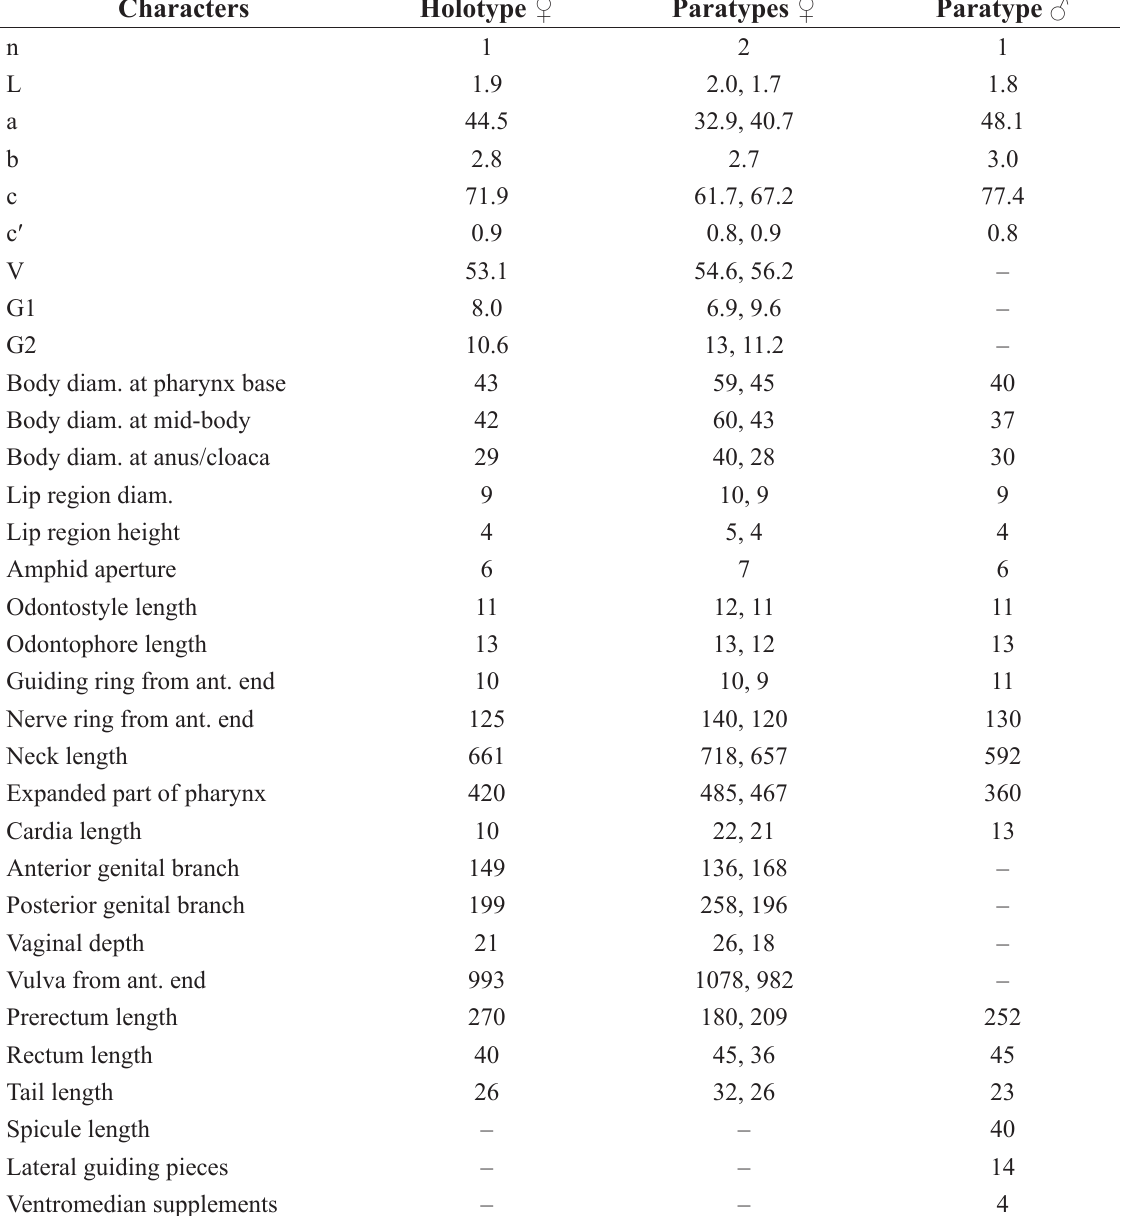
Table 9. Measurements of Axonchium tropicum sp. nov. All measurements in µm except L in mm, and measurements for each female (n = 2) separated by a